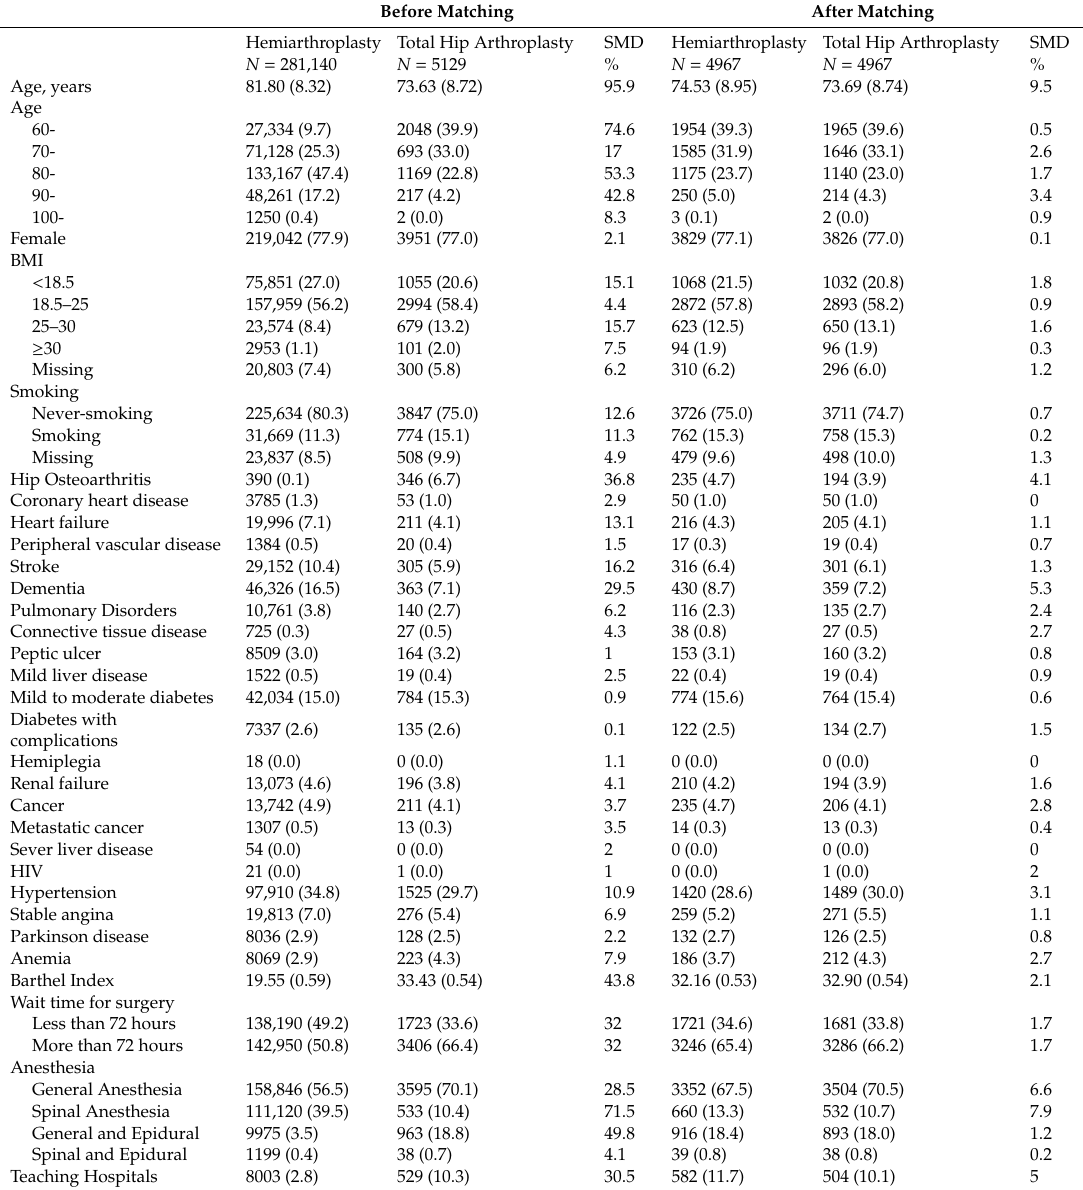
Table 1. Patient